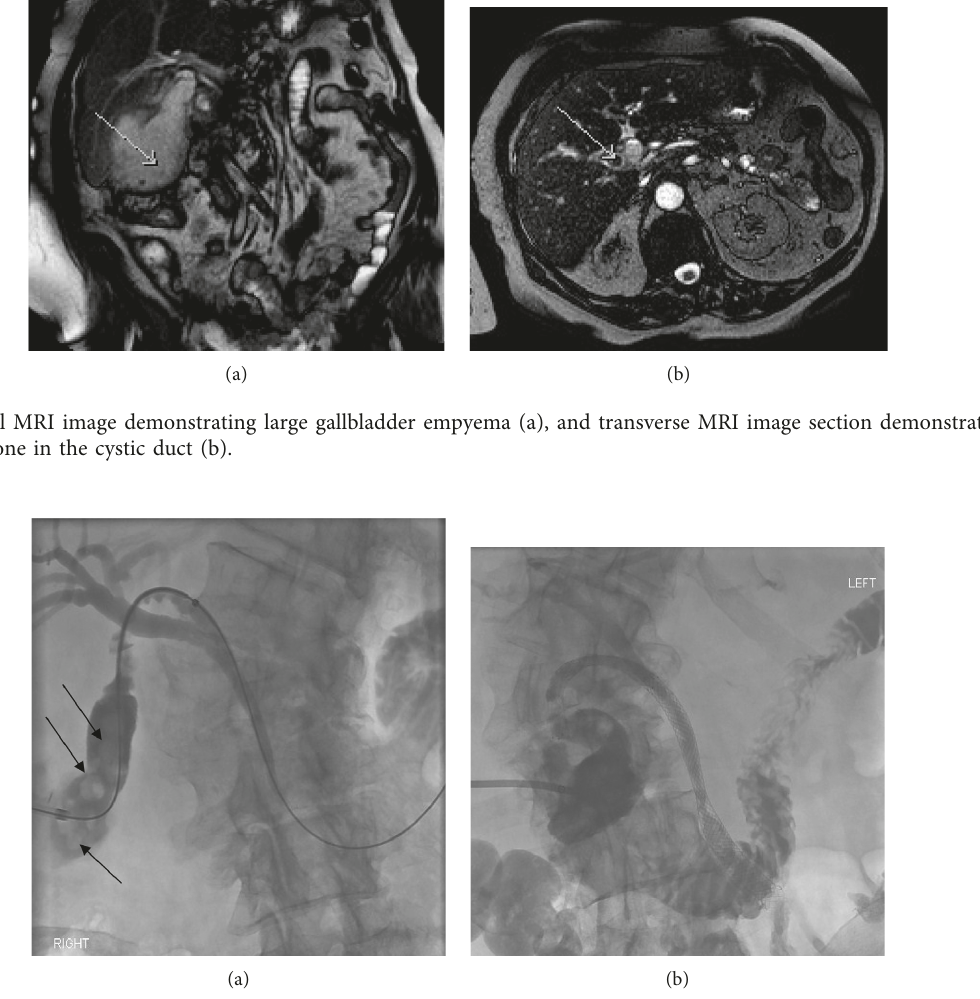
Figure 2: Fluoroscopy-guided insertion of a collapsed 6 mm × 60mm bare metal stent into the cystic duct prior to deployment (a). Note the round filling defects, consistent with gallbladder calculi (arrows). Subsequent successful deployment of a 6mm × 60mm bare metal stent in the cystic duct, and an 8mm × 100mm bare metal stent in the common bile duct and duodenum, with antegrade contrast clearance